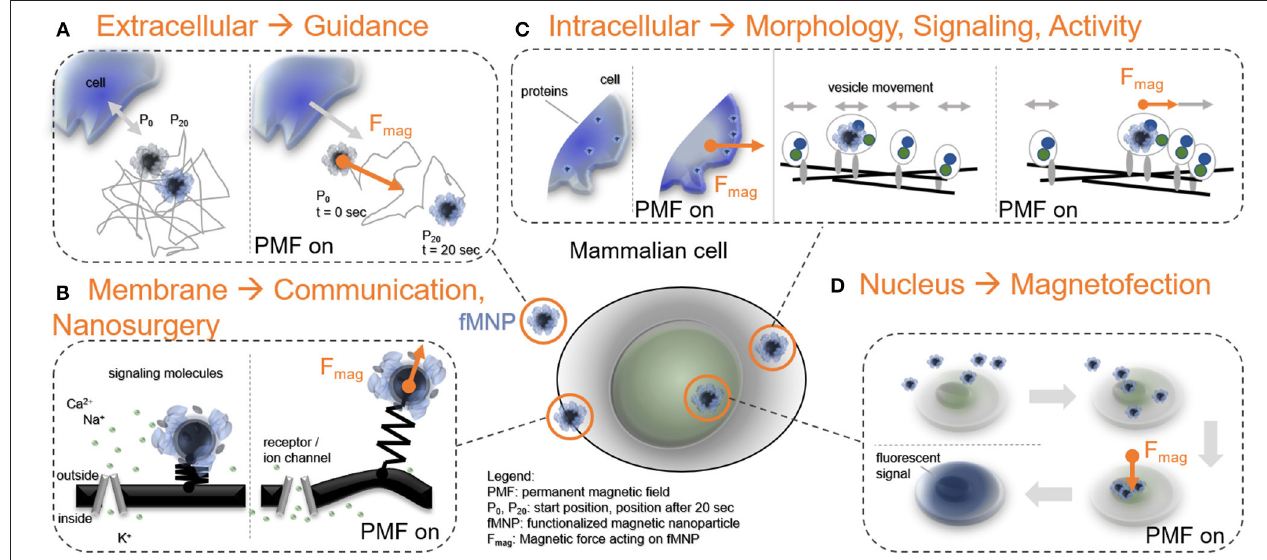
FIGURE 1 | Force-mediating nanoparticles and their interplay with mammalian cell function. (A) FMNPs as mediators to direct cell guidance through the extracellular space when exposed to a permanent magnetic field gradient (t: time). (B) FMNPs associated to the cell membrane can control receptor functionality, stimulate cell communication, or perform local cell surgeries. (C) Positioning of fMNPs inside cells can establish protein gradients and modulate vesicle dynamics. (D) Localizing FMNPs to the cell nucleus is utilized to genetically modify cells, here demonstrated through the translation of a fluorescent protein (e.g., GFP, or